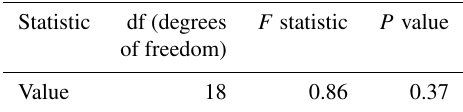
Table B1. Table displaying F -test results for the 2015–2016 drought period risk assessment versus literature results.